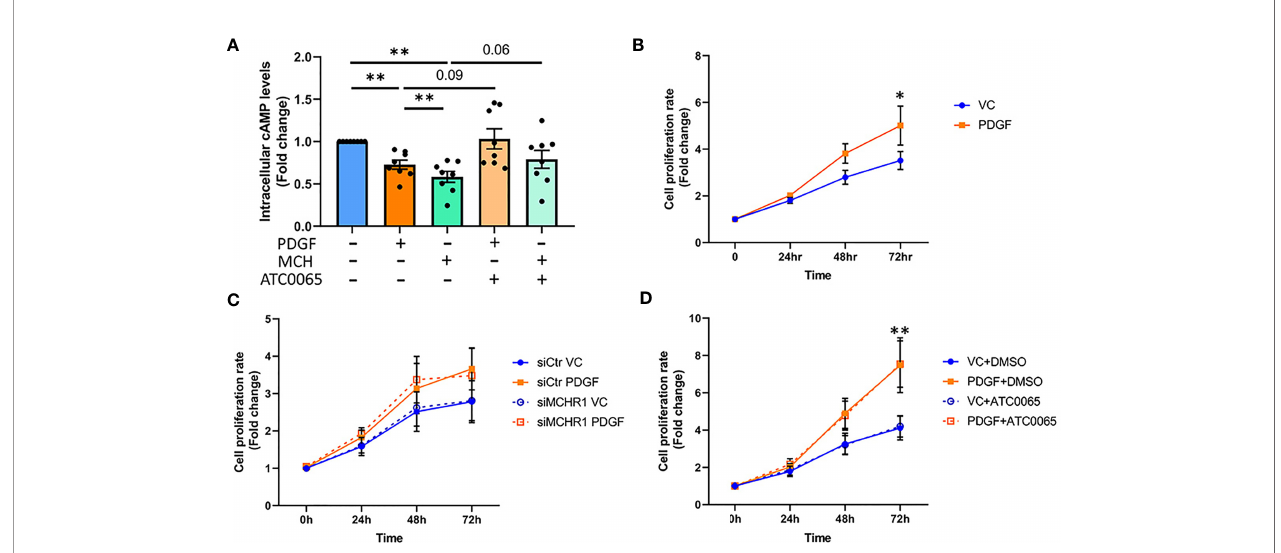
FIGURE 5 | Effect of PDGF-BB on fi broblast cAMP levels and cell proliferation. (A) Cyclic adenosine monophosphate (cAMP) levels in NHDF treated with PDGF-BB (40ng/ml) or melanin concentrating hormone (MCH, 10 -7 M) for 30min. Cells were incubated with 50nM MCHR1 inhibitor (ATC0065) or DMSO as a vehicle control prior to treatment (n=8). Normalized cAMP levels in control cells were set at 1. (B) The cell proliferation rates of NHDF treated with PDGF-BB (40ng/ml) were measured at the indicated time points (n=5). (C) The cell proliferation rate in MCHR1 silenced NHDF (siMCHR1) and control NHDF (siCtr) stimulated with PDGF-BB (40ng/ml) or vehicle control (VC) were assessed at the indicated time points (n=5). (D) The cell proliferation rate was assessed in NHDF treated with 50nM of MCHR1 inhibitor (ATC0065) or DMSO as vehicle control 1 hr prior to PDGF-BB (n=3). Normalized absorbance at 0 h was set at 1. *P < 0.05, **P < 0.01, error bars =